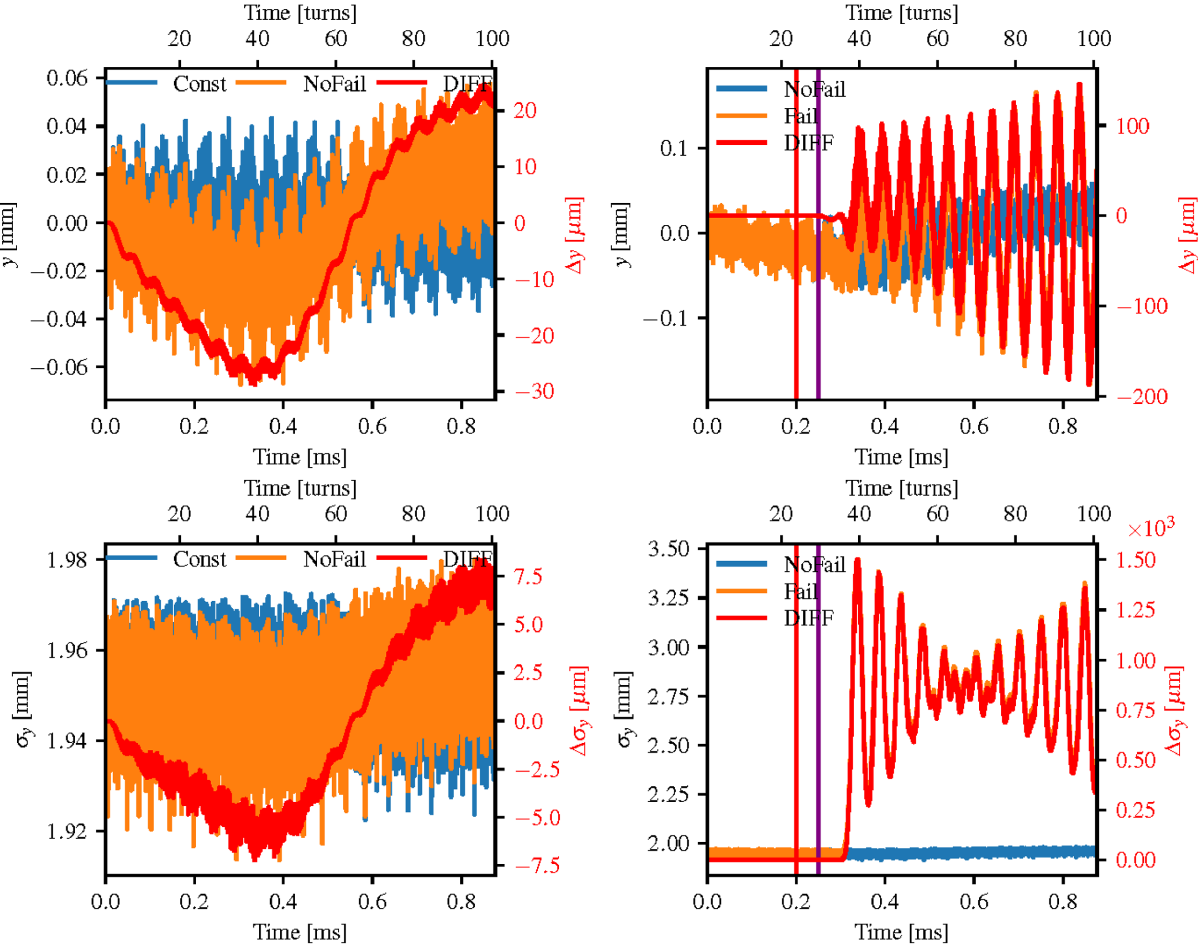
FIG. 18. Vertical beam position (top) and size (bottom) at the controlled crab cavity in the SPS/55 GeV, comparing NoFail vs Const (left) and Fail vs NoFail (right). For the Fail scenario, the first vertical line (red) marks the beginning of the quench, and the second line (purple) the time when pressure detuning becomes